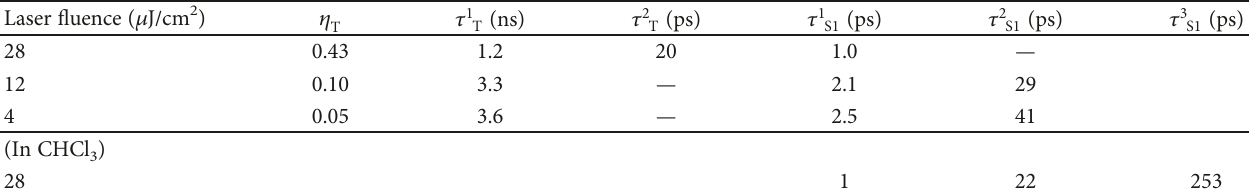
) together with the lifetimes of triplet T